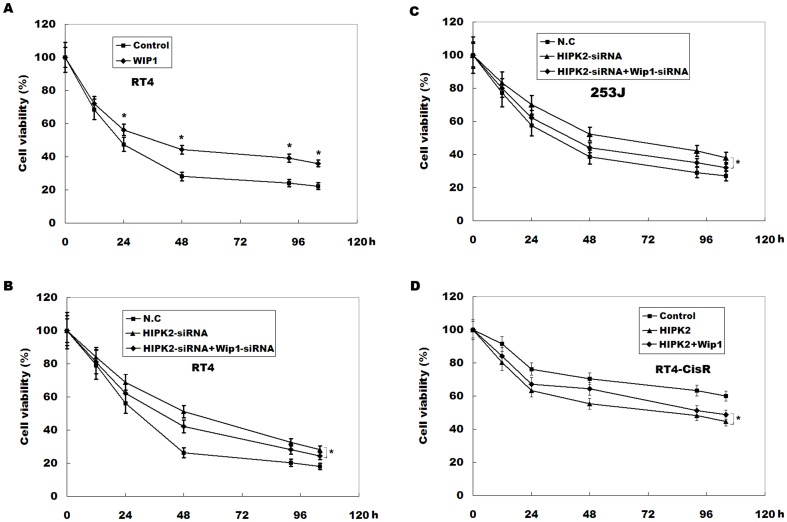
HIPK2 overexpression sensitizes chemoresistant bladder cancer cell to cisplatin by regulating Wip1 expression.(A) Wip1 was overexpressed in RT4 cells, and cell viability was assayed by using MTT following cisplatin treatment (6 µM). The results show data from six independent experiments, expressed as the mean ± SD. *p<0.05. (B and C) RT4 and 253J cells were treated with HIPK2-siRNA or HIPK2-siRNA plus Wip1-siRNA, and at the indicated time points, cell viability was assayed by using MTT following cisplatin treatment (6 µM). (D) HIPK2 or HIPK2 plus Wip1 was overexpressed in RT4-CisR cells, and cell viability was assayed by using MTT following cisplatin treatment (6 µM). *p<0.05.